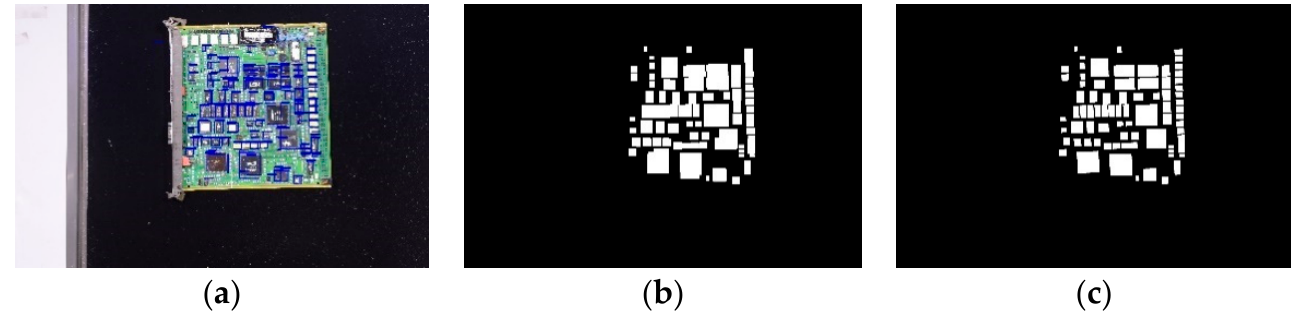
Figure 3. Example of IC (integrated circuit) detection for an entire image: ( a ) YOLO (object detection model) raw IC detection for the entire WPCB (waste printed circuit board)—a blue bounding box is drawn on each detected IC; ( b ) Predicted IC mask area—all the bounding boxes are filed and combined over a black background; ( c ) Ground truth IC area—the mask built on the ground truth bounding boxes.